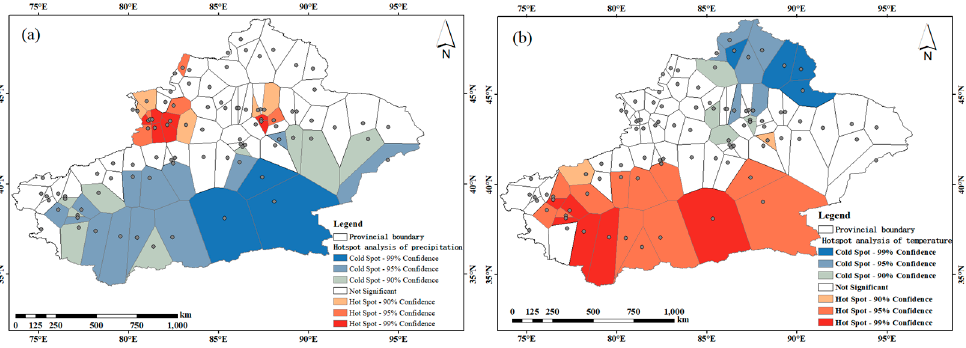
Note: All p values are less than 0.01.